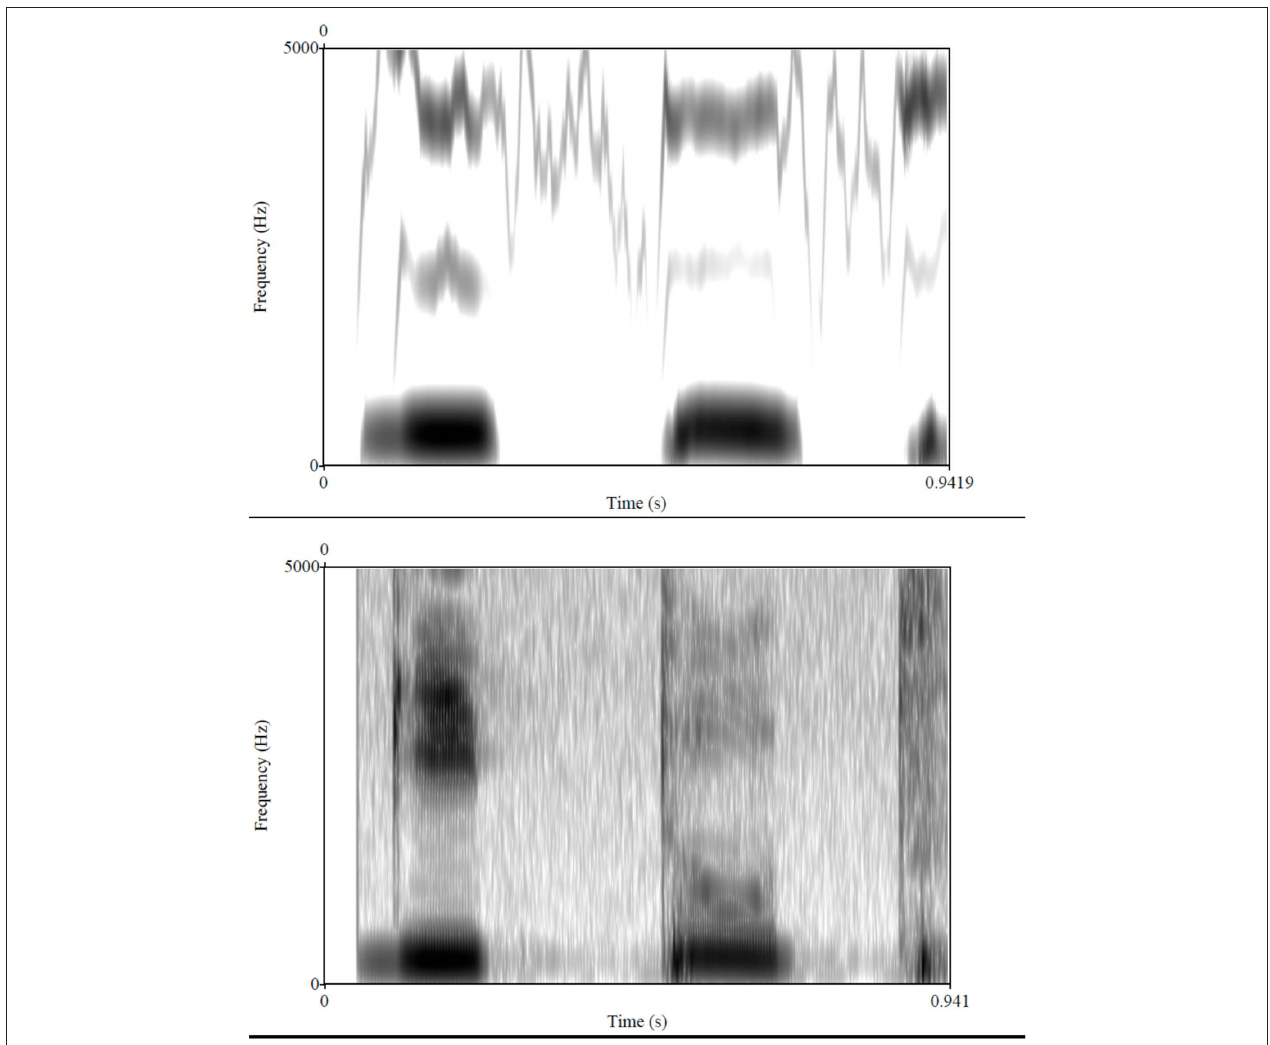
Figure 5 | Spectrograms for the novel Hebrew word “gitut.” The top panel is a non-speech stimulus; the bottom one depicts natural